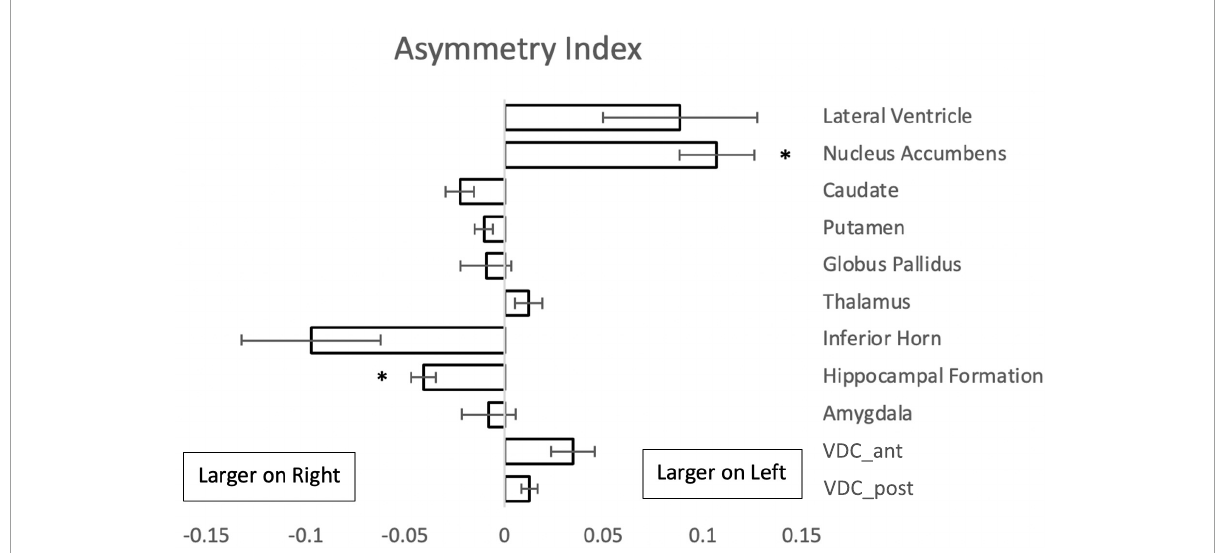
FIGURE4 Asymmetry index {(L - R)/[0.5(L + R)]} for paired subcortical structures from 50 subjects. Negative values indicate a larger volume of the right structure. Asterisks signify a significant difference ( p < 0.01 with Bonferroni correction for multiple comparisons); error bars represent standard error of the mean. Abbreviations: VDC_ant, anterior ventral diencephalon; VDC_post, posterior ventral diencephalon.